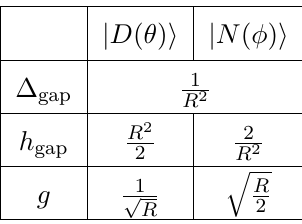
Table 1. Bulk and boundary gaps and brane tensions on the c = 1 circular branch.